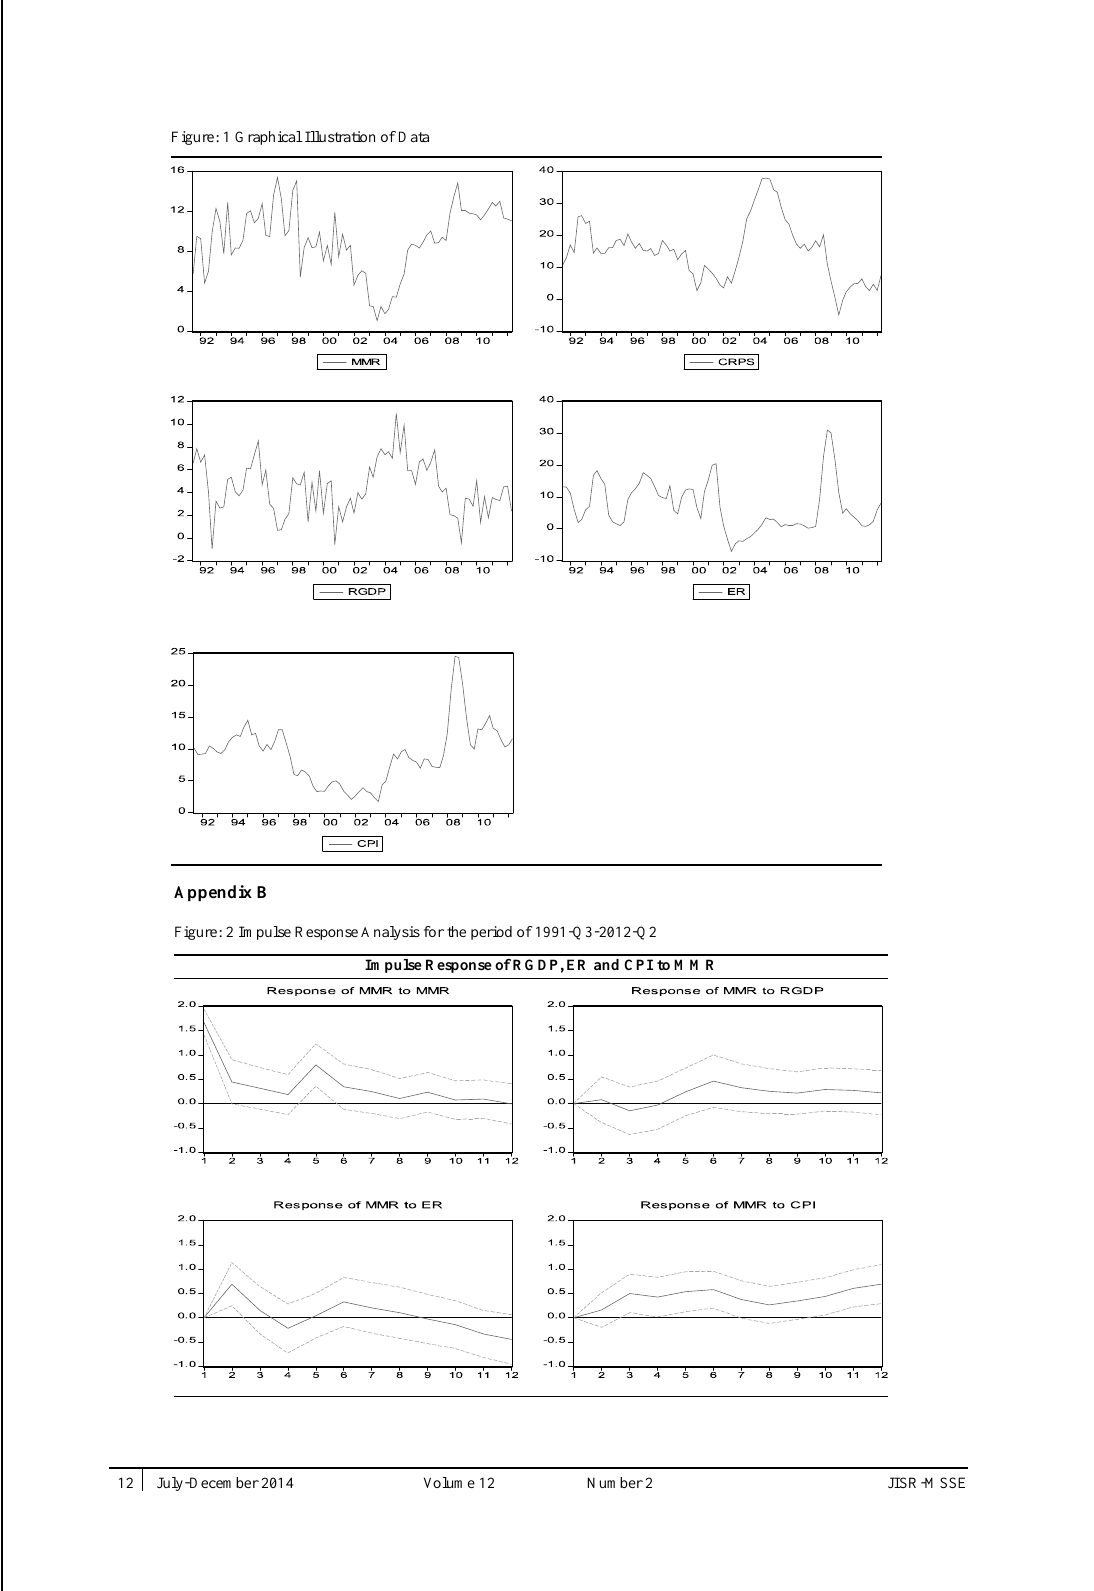
Figure: 1 Graphical Illustration of Data